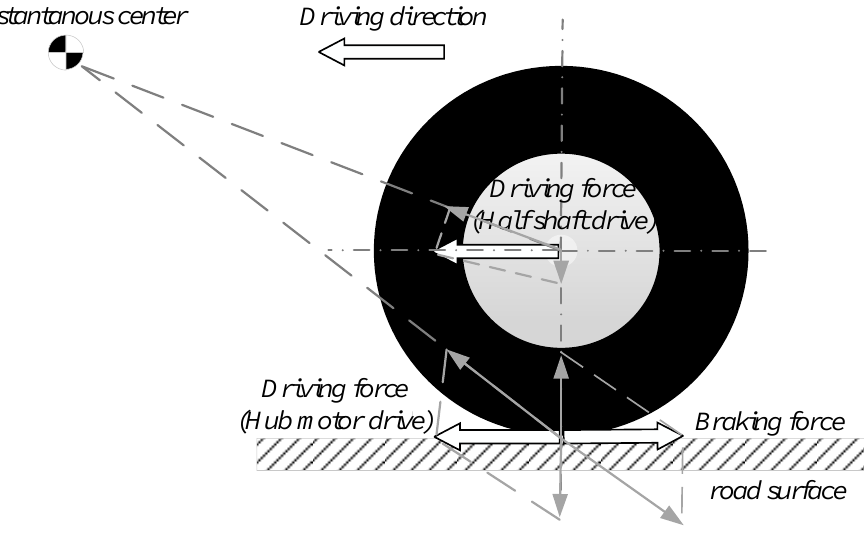
Figure 1. Hub motor drive versus half shaft drive.